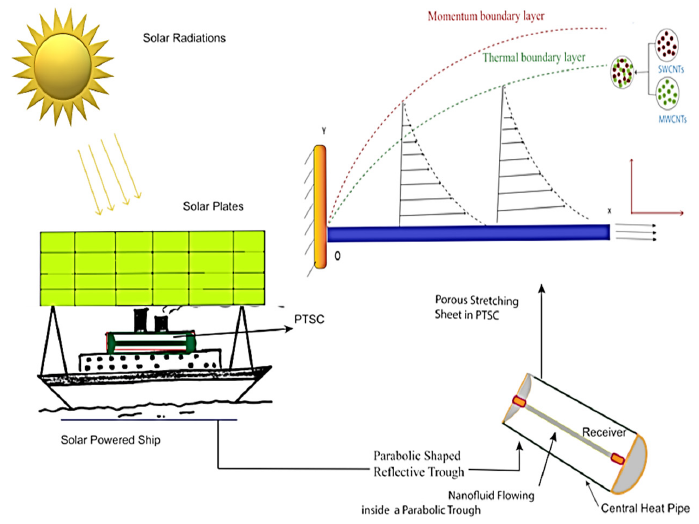
Figure 2. Schematic view of PTSC.